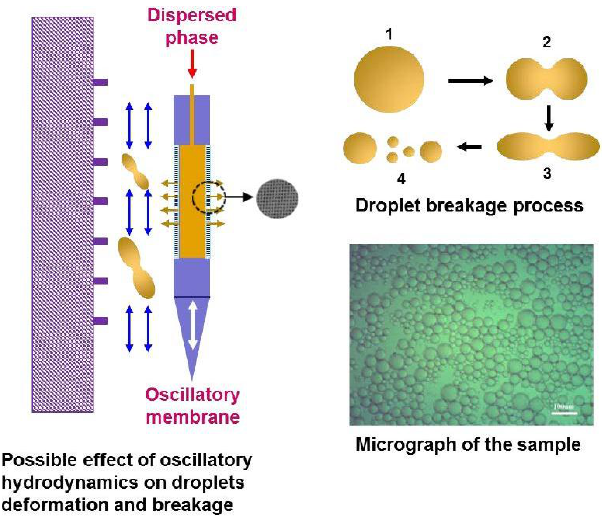
Figure 5. Schematic illustration of a proposed mechanism of droplet breakage at high oscillations. Micrograph is for dispersed phase flux J = 30 LMH, oscillation frequency = 14.8 Hz, amplitude = 10 mm.